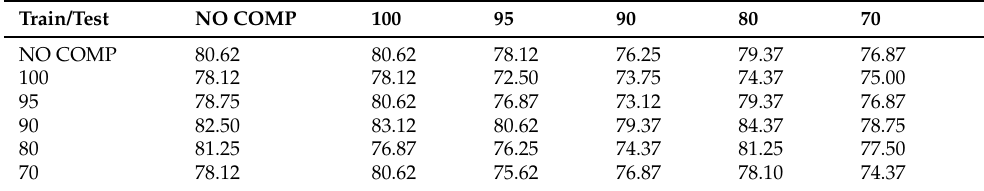
Table 8. Accuracy obtained by FN 128 with different JPEG quality factors (reported in percentage).